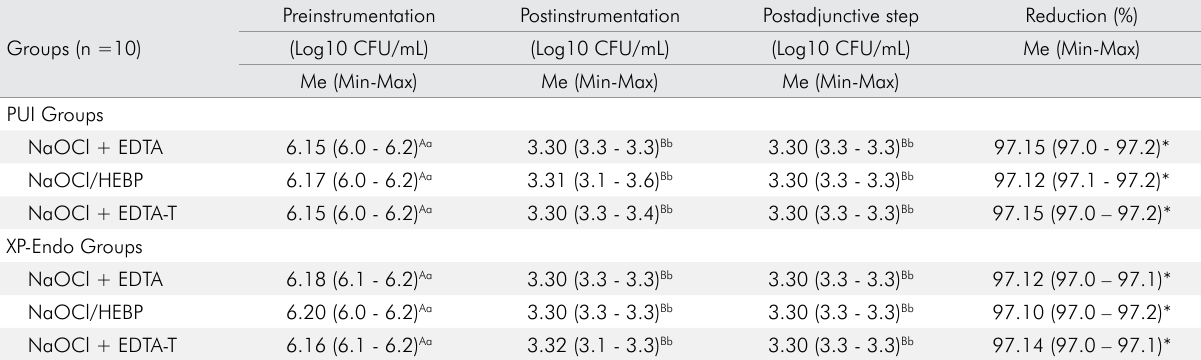
Table 1. Median (Me), minimum and maximum (Min-Max) CFU/mL and E. faecalis percent reduction (%) inside root canals for each experimental group.